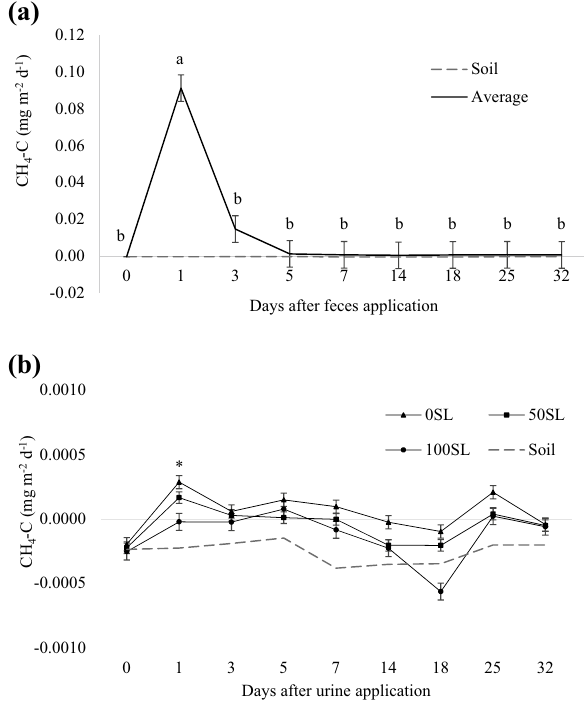
Figure 3. Net flux of CH 4 emitted by ( a ) feces from beef steers fed sericea lespedeza [SL; Lespedeza cuneata (Dum. Cours.) G. Don], where values represent the average of three diets (0, 50 or 100% SL) in two experimental periods, and means followed by different letters are significantly different among sampling days ( P day < 0.001); and ( b ) urine collected from beef steers fed 0SL, 50SL or 100SL, where asterisk indicates differences among diets within day ( P SL*Day < 0.001). Bars refer to standard deviation. Dashed line represents soil (no excreta)